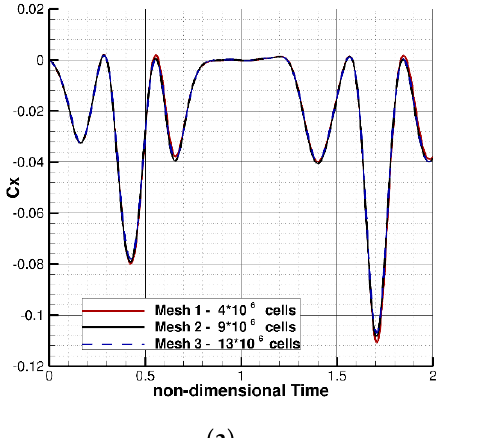
Figure 13. RANSE solver grid: ( a ) Overall view of the spherical domain used for the computational domain spanning 100 chords. The grid is fully unstructured as can be seen by a slice of the grid, as shown above; ( b ) detail of the grid in the near wall vicinity. A slice of the computational mesh is depicted, and a structured-like grid is generated to resolve the boundary layer.